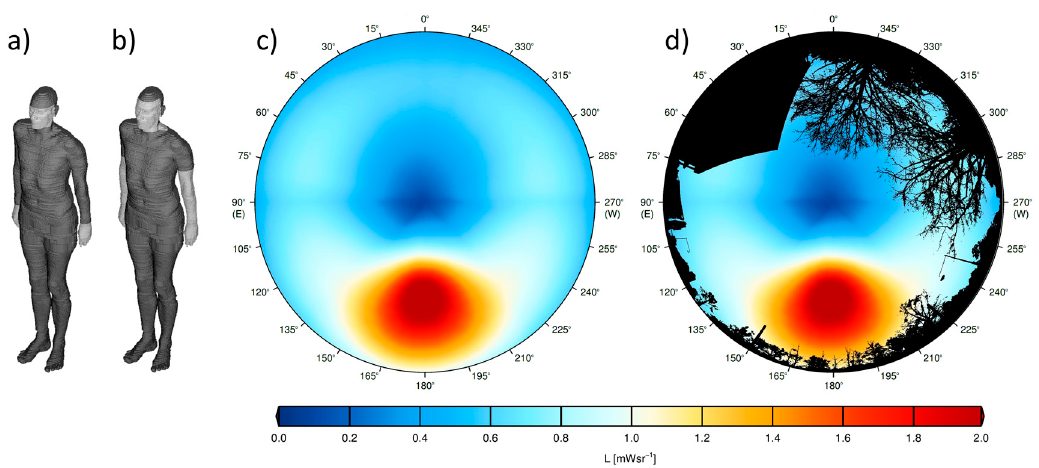
Figure 1. Hemispherical image taken in front of the Institute of Meteorology and Climatology of the Leibniz Universität Hannover ( left ) and the image with the derived obstruction information ( right ), where the derived obstructions shadowing the sky are shown in black and sky in white. The image is segmented by the grid shown, which illustrates the different directions (sky segments). The ratio of the amount of pixels characterized as obstructions and the total pixel count results in 39% obstructed sky.